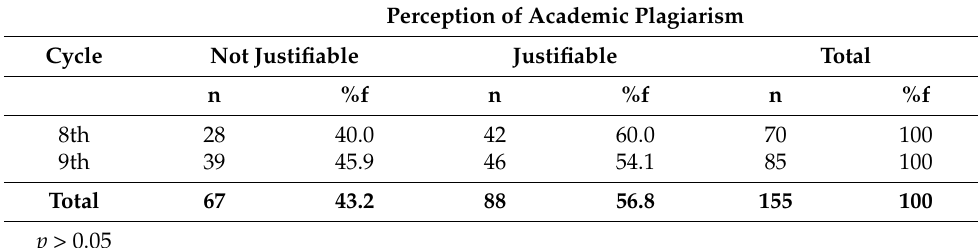
Table 7. Level of perception of academic plagiarism in students at the school of industrial engineering of a public university in Lima according to study